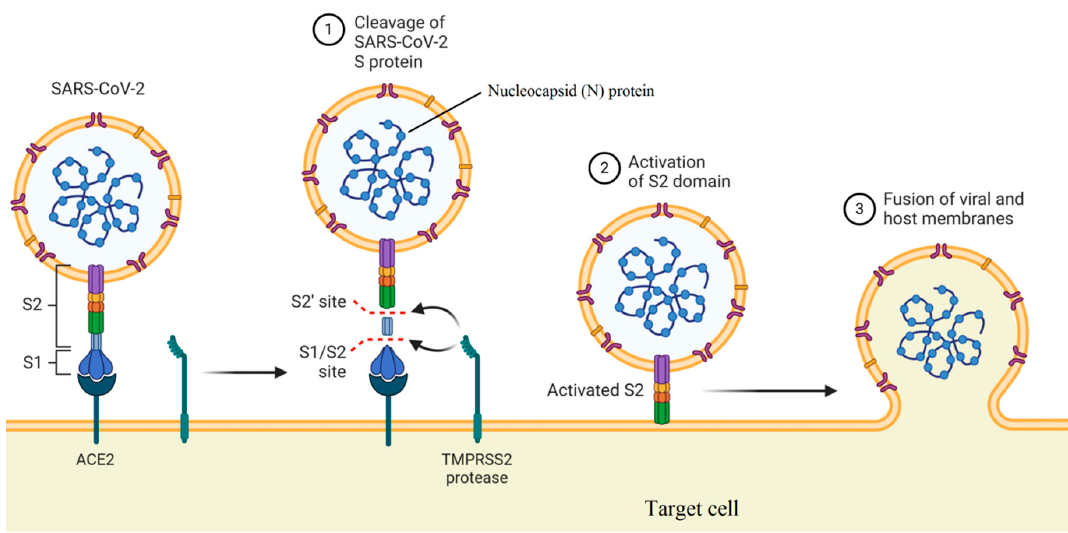
Figure 2. Mechanism of viral entry by function of two subunits of the spike protein (created in Figure2. BioRender.com).